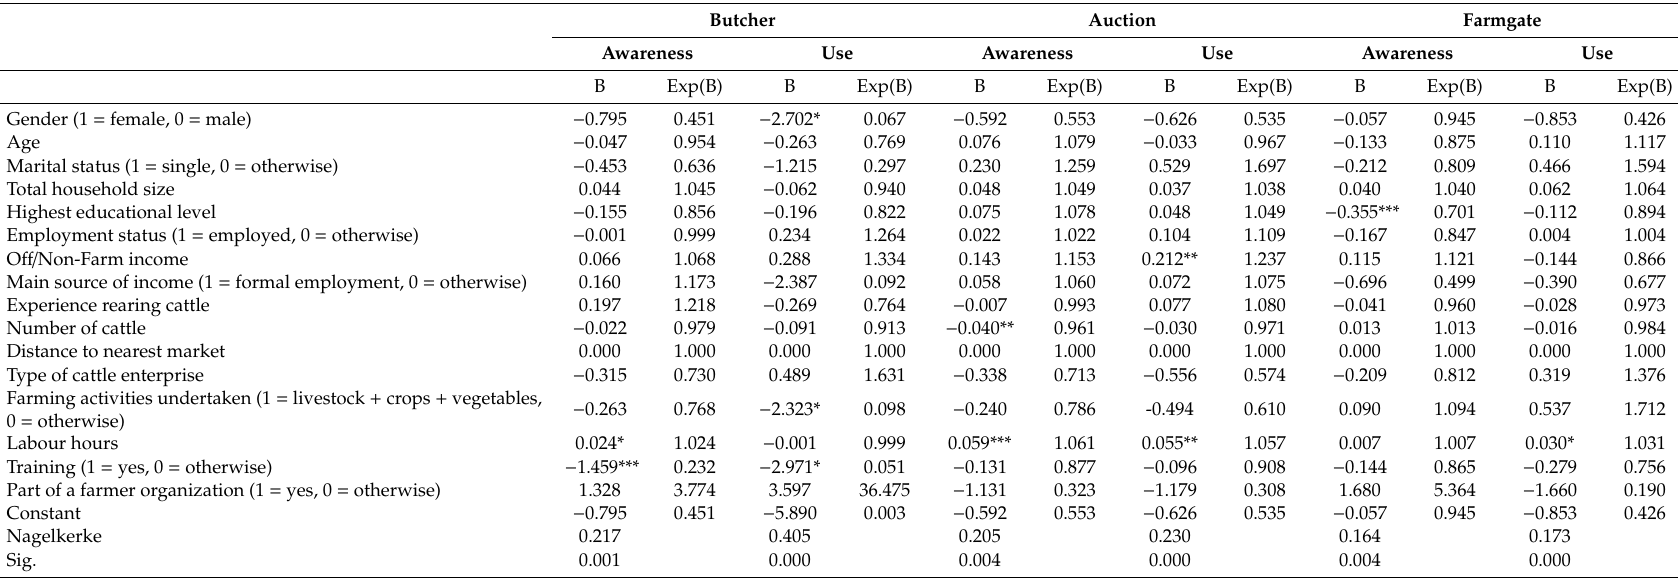
Table 5. Determinants of awareness and use of butcher, auction and farmgate markets for KyD scheme farmers. Butcher Auction Farmgate Awareness